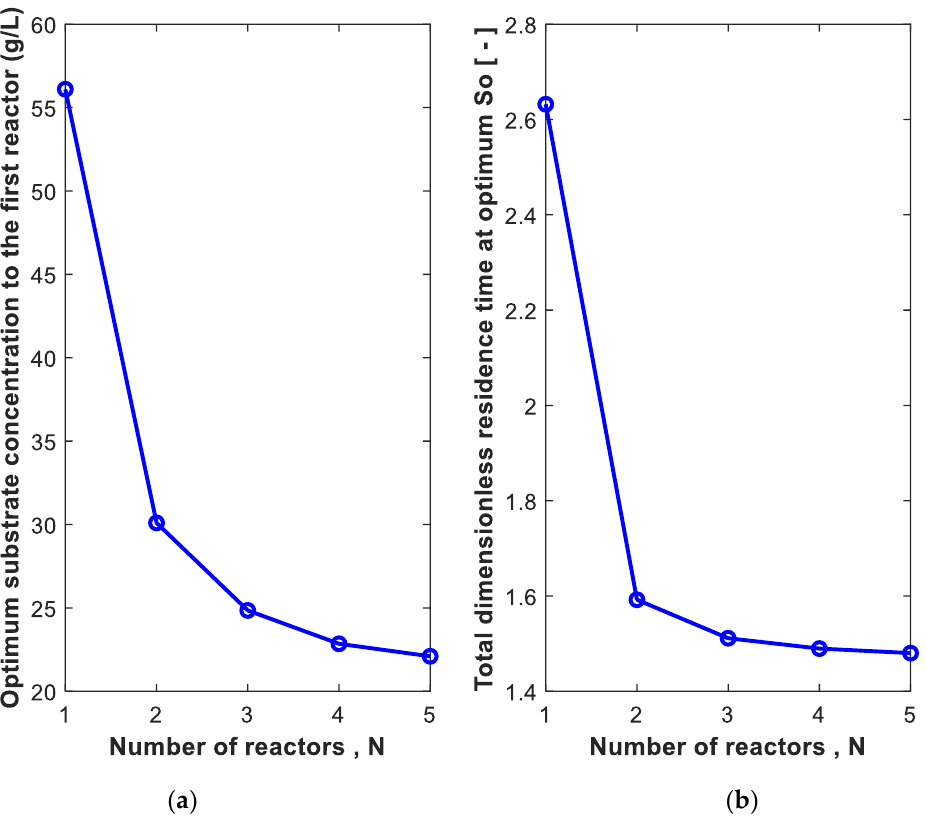
Figure 5. The substrate concentration in the feed to the first reactor ( a ) at which the total optimum dimensionless residence time ( b ) is minimum for N reactors in series. Substrate conversion: 99%. X o = 0.01 g/L. P o = 0.